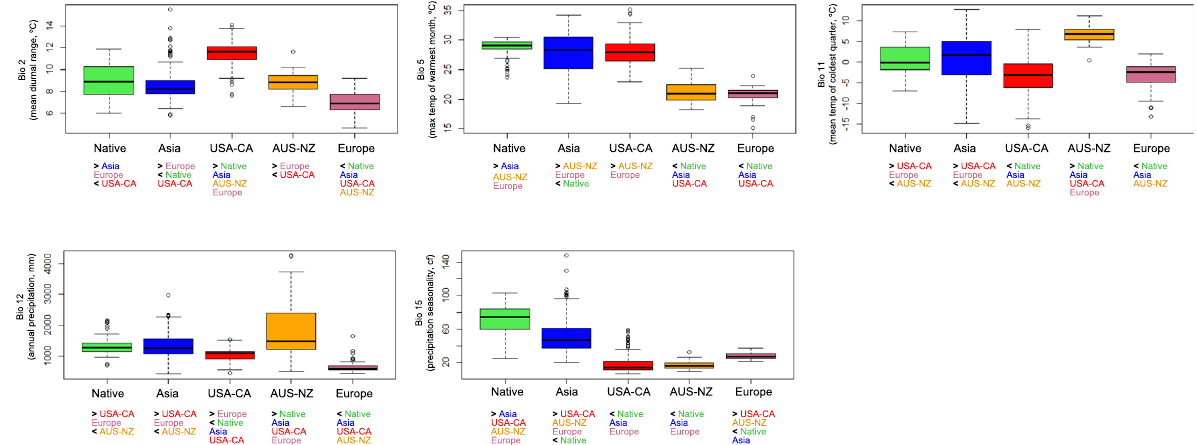
Figure 3. Boxplots of five climatic variables selected for the native (Korea), archaeophyte (ASIA), and neophyte (USA-CA, AUS-NZ, EUR) ranges of Lilium lancifolium . Significant differences ( p < 0.05) for the climatic variables between regions are indicated by > or < symbols below each plot (see Appendix B, Table S2 in Electronic Supplementary Material for